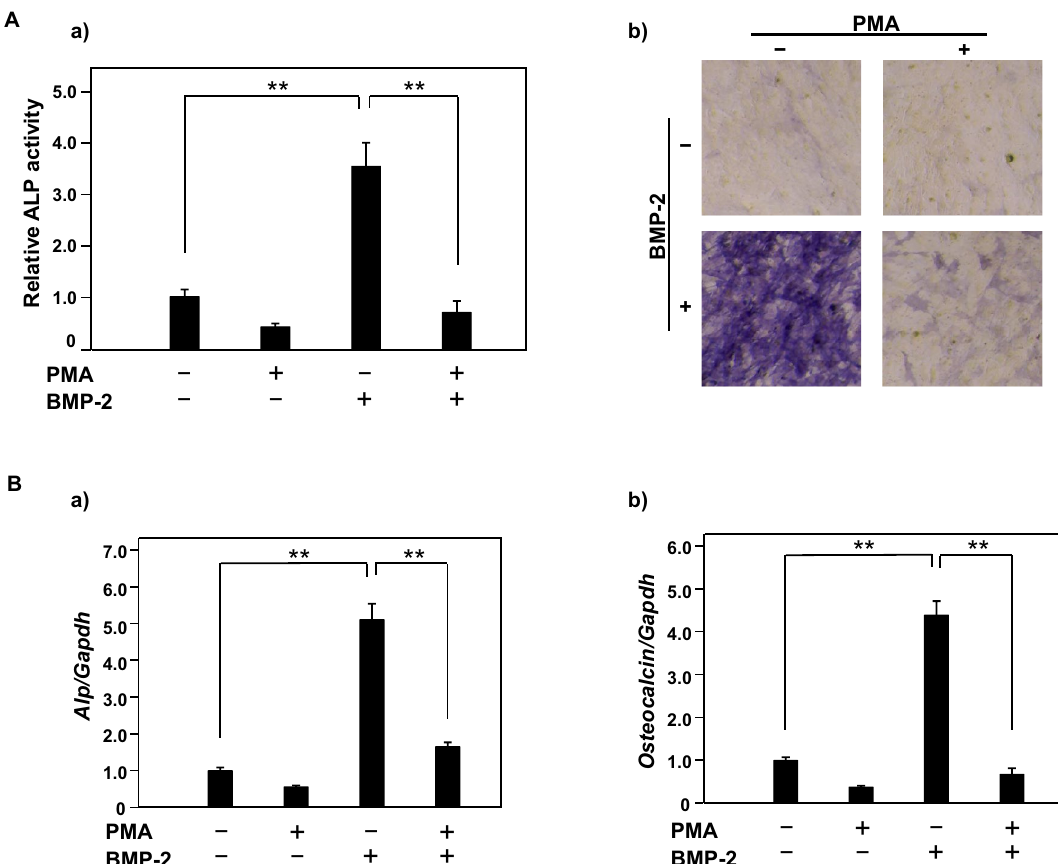
Figure 1. Effects of PMA on BMP-2 induced osteoblast differentiation in MT3T3-E1 cells. ( A ) ( a ) MC3T3-E1 cells were treated with or without BMP-2 (100 ng/ml) in the presence or absence of PMA (5 nM) for three days. For quantification of ALP activity, cells were disrupted by sonication in 50 mM Tris–HCl containing 0.1% NP40. ALP activity was determined following incubation with the substrate p-nitrophenylphosphate and using absorbance at 405 nm. ( b ) For ALP staining, cells were fixed using 10% formalin in PBS and then ALP activity was visualized using a mixture of 0.1 mg/ml Naphthol As-Mx, 0.6 mg/ml phosphate, and Fast blue BB salt. ( B ) Total cellular RNA was extracted, then mRNA levels of Alp, Osteocalcin , and Gapdh were examined using quantitative real-time PCR analysis. Results are shown as the mean ± SD of three samples. ** P < 0.01, Student’s t